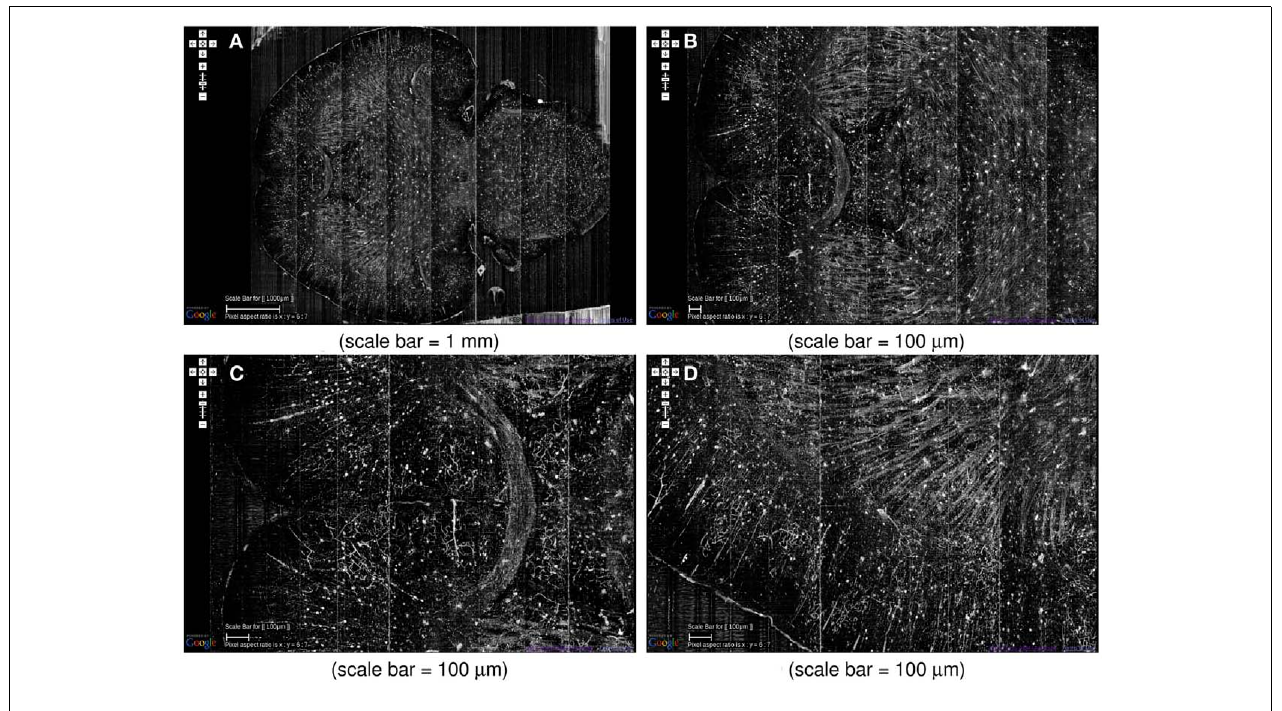
(B,C) Zoomed in view showing the anterior commissure near the middle. (D) Close-up of the fiber bundles in the striatum can be seen. A large number of apical dendrites in the adjoining cortex can also be seen.